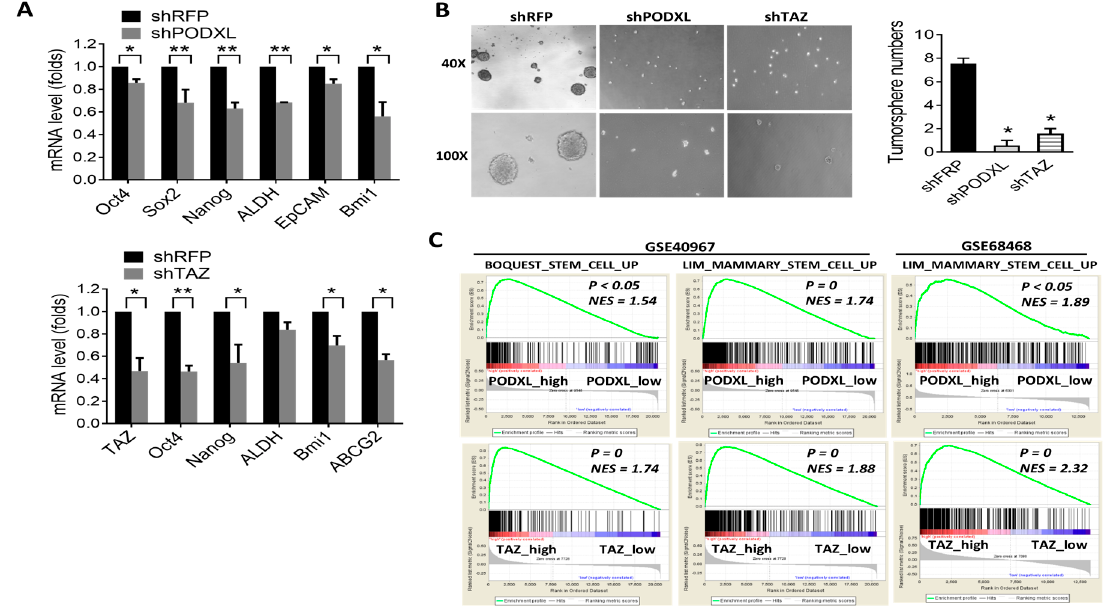
Figure 3. Expressions of PODXL and TAZ are associated with the stem cell signature in colorectal cancer. ( A ) Real-time PCR analysis of pluripotent stem cell markers and cancer stem-like gene expressions in PODXL- (upper panel) and TAZ-knockdown (lower panel) HCT15 cells. * p < 0.05; ** p < 0.01, as assessed by an unpaired t -test. ( B ) Knockdown of PODXL and TAZ-suppressed tumorsphere formation in HCT15 cells. Pictures were taken under a reverse microscope at 40 × (upper panel) or 100 × (lower panel) magnification. * p < 0.05 as assessed by an unpaired t -test. ( C ) Correlations of PODXL and TAZ with stem cell-related gene signatures. Data were retrieved from gene expression omnibus (GSE68468 and GSE40967). NES, normalized enrichment